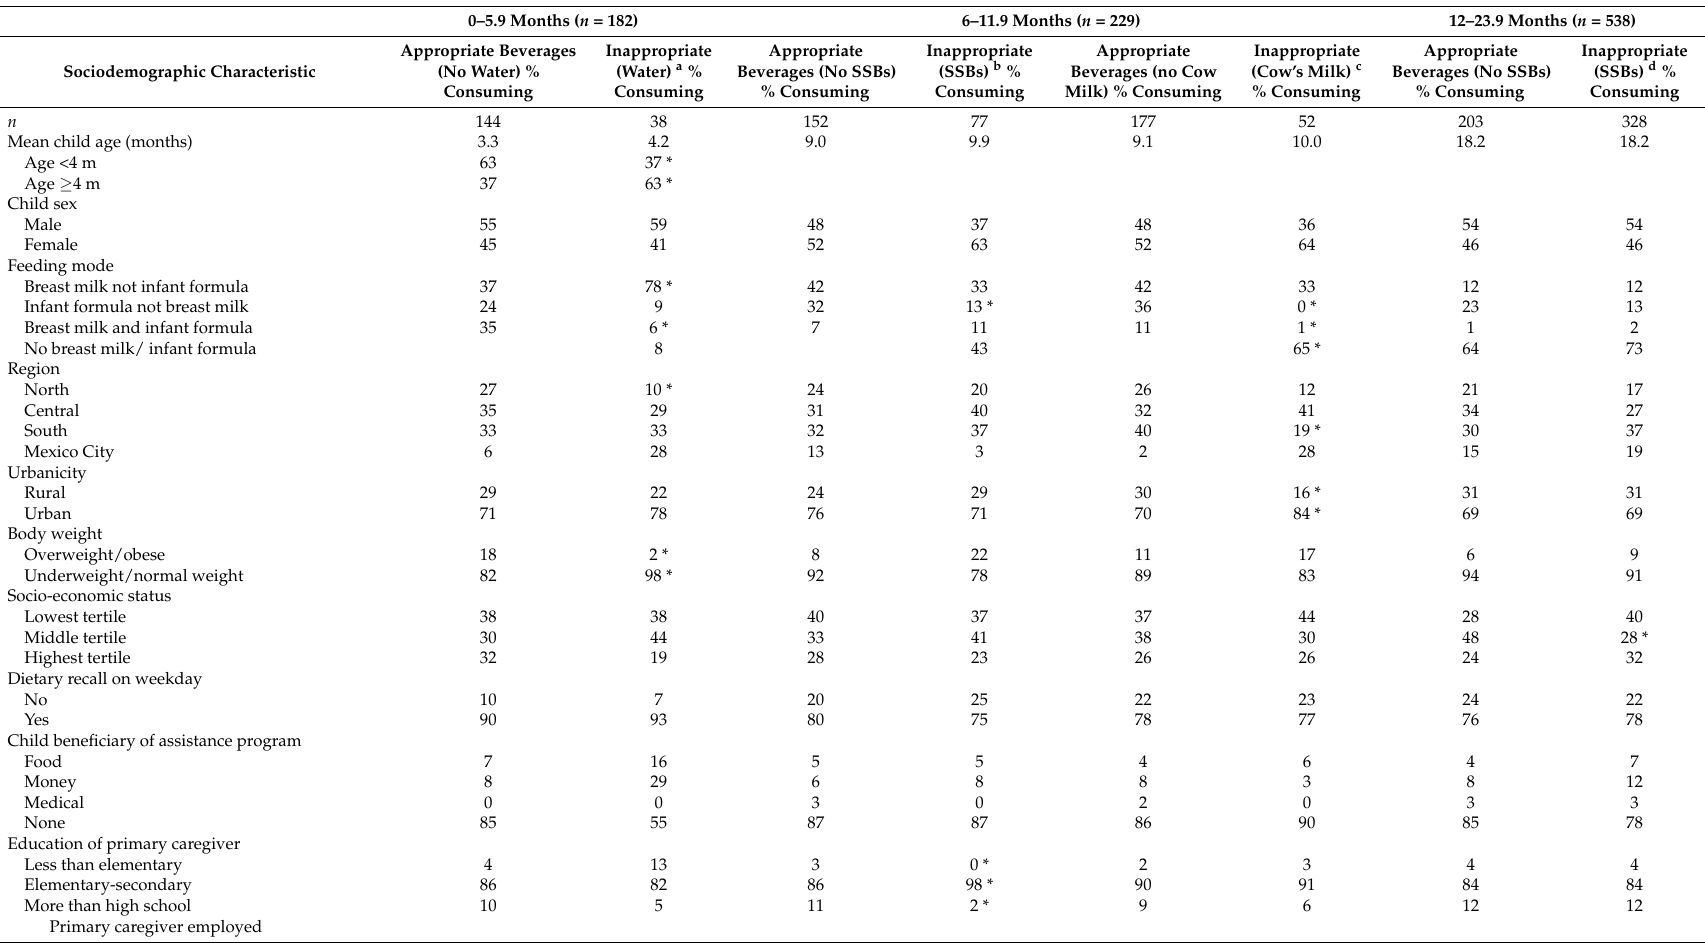
Table 4. Appropriate and inappropriate milk and beverage consumption among Mexican infants and toddlers by age and socio-demographic characteristics (ENSANUT